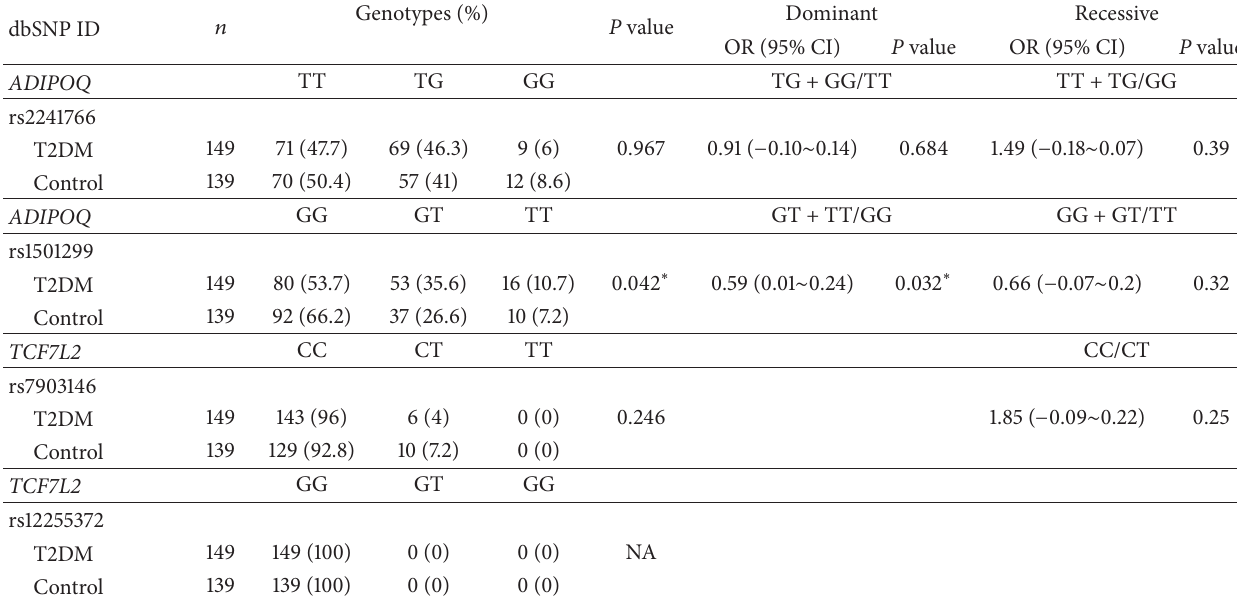
Table 4: Genotype frequencies (%) of SNPs: T2DM and